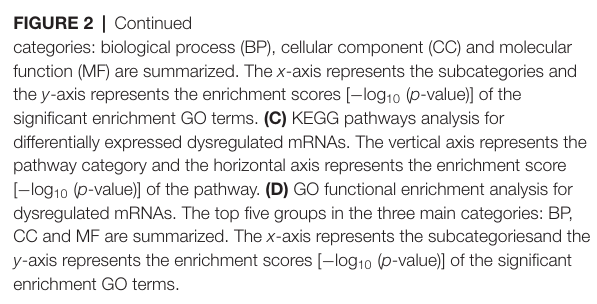
FIGURE 2 | Continued categories: biological process (BP), cellular component (CC) and molecular function (MF) are summarized. The x -axis represents the subcategories and the y -axis represents the enrichment scores [ − log 10 ( p -value)] of